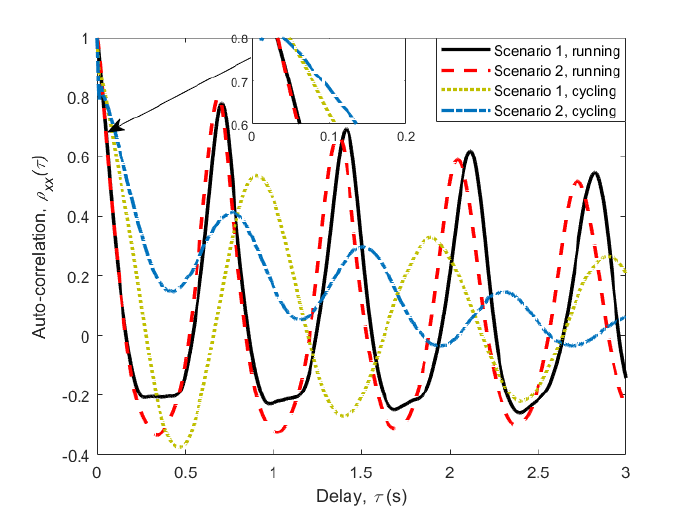
Figure 5. The auto-correlation function of all measured scenarios with a delay of up to 3 s.